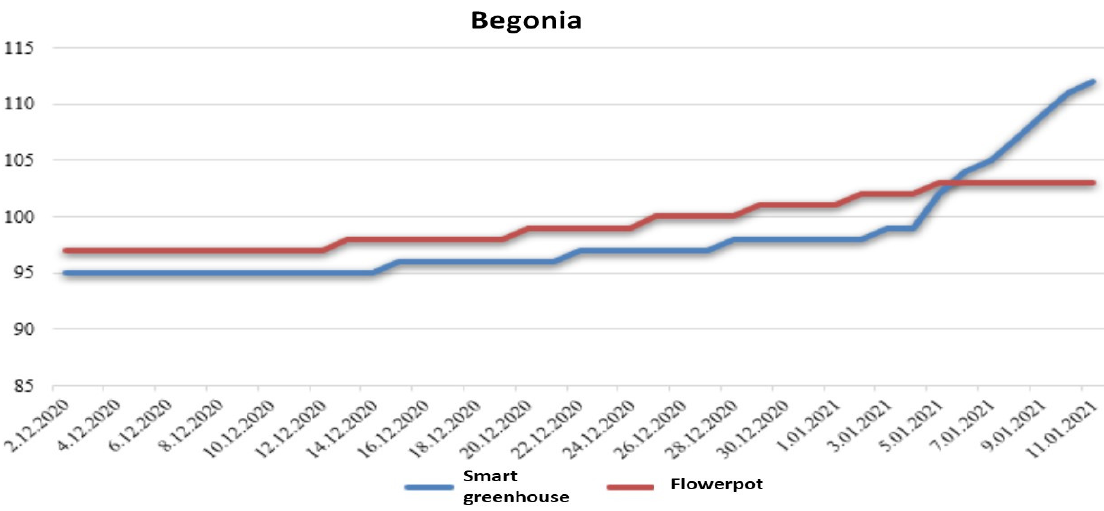
Figure 13. Development graph of begonia flower in smart greenhouse and pot.